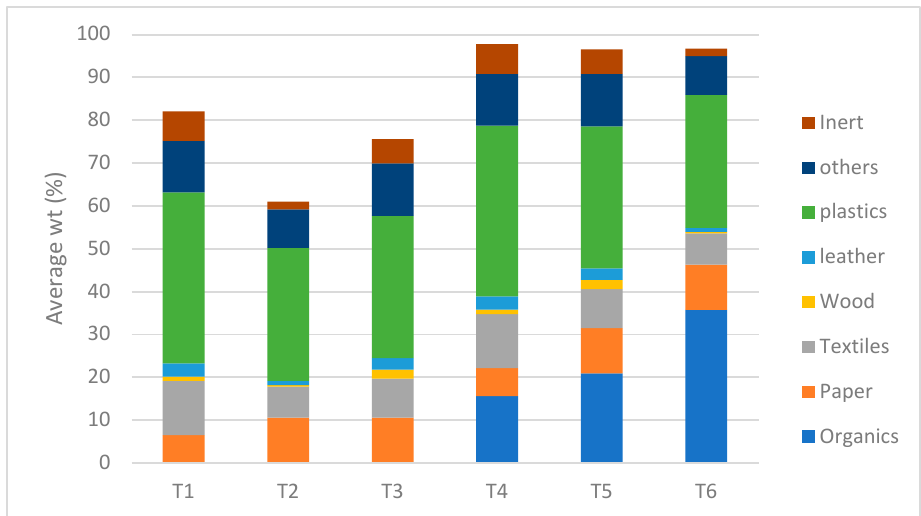
Figure 5. The average composition of RDF from the RF.